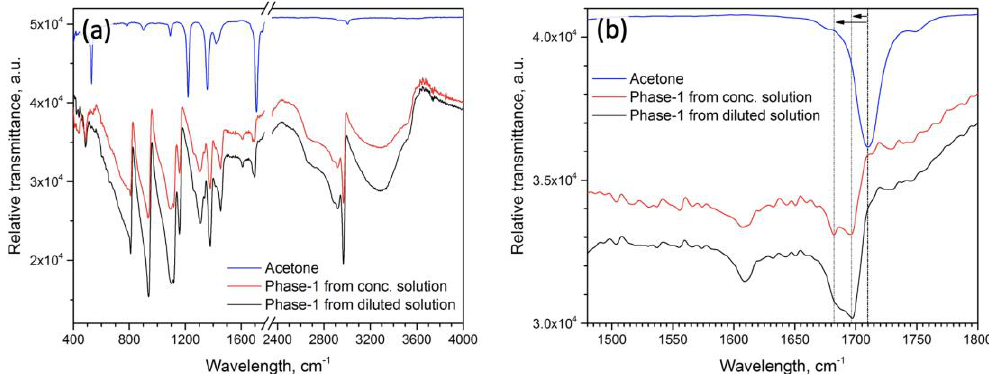
Figure 2. IR-spectrum of the Phase-1 crystals crystallized from saturated (red line) and diluted (black line) solutions in comparison with pure acetone (blue line): ( a ) full spectra and ( b ) region of C=O group stretching vibration—the position in pure acetone indicated by black dashed line and the shifted and split C=O vibration in Phase-1 indicated by dark-grey lines.